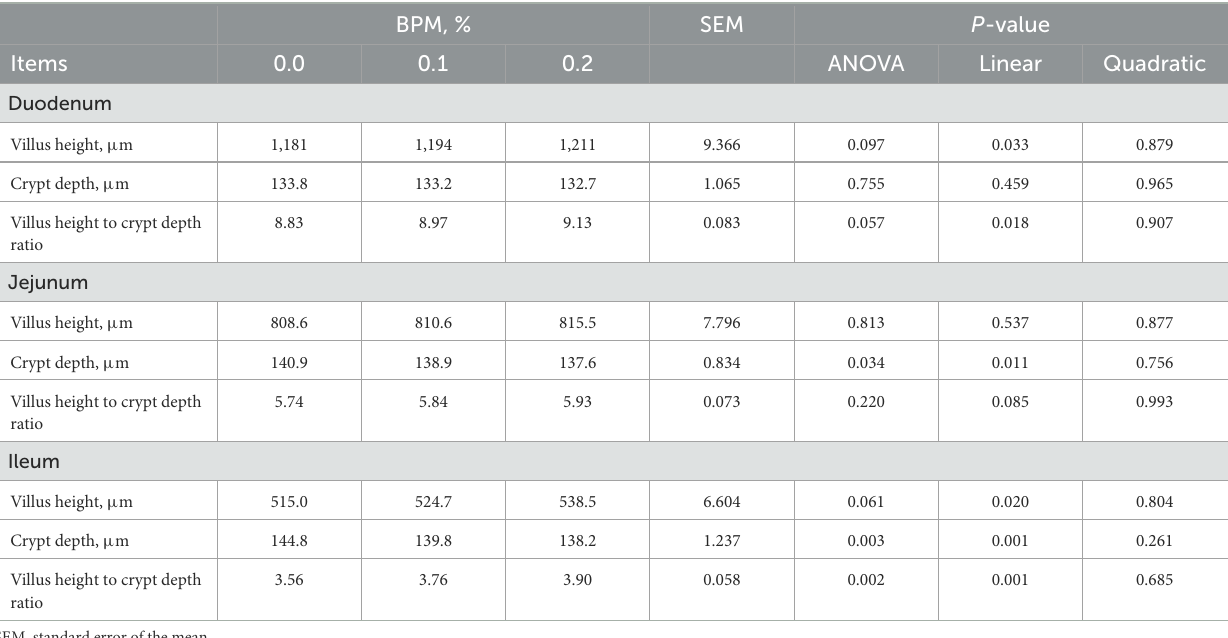
TABLE 6 Effect of dietary supplementation of Bacillus subtilis and Pichia farinose mixture (BPM) on duodenal, jejunal, and ileal morphology of broiler chicks ∗ .